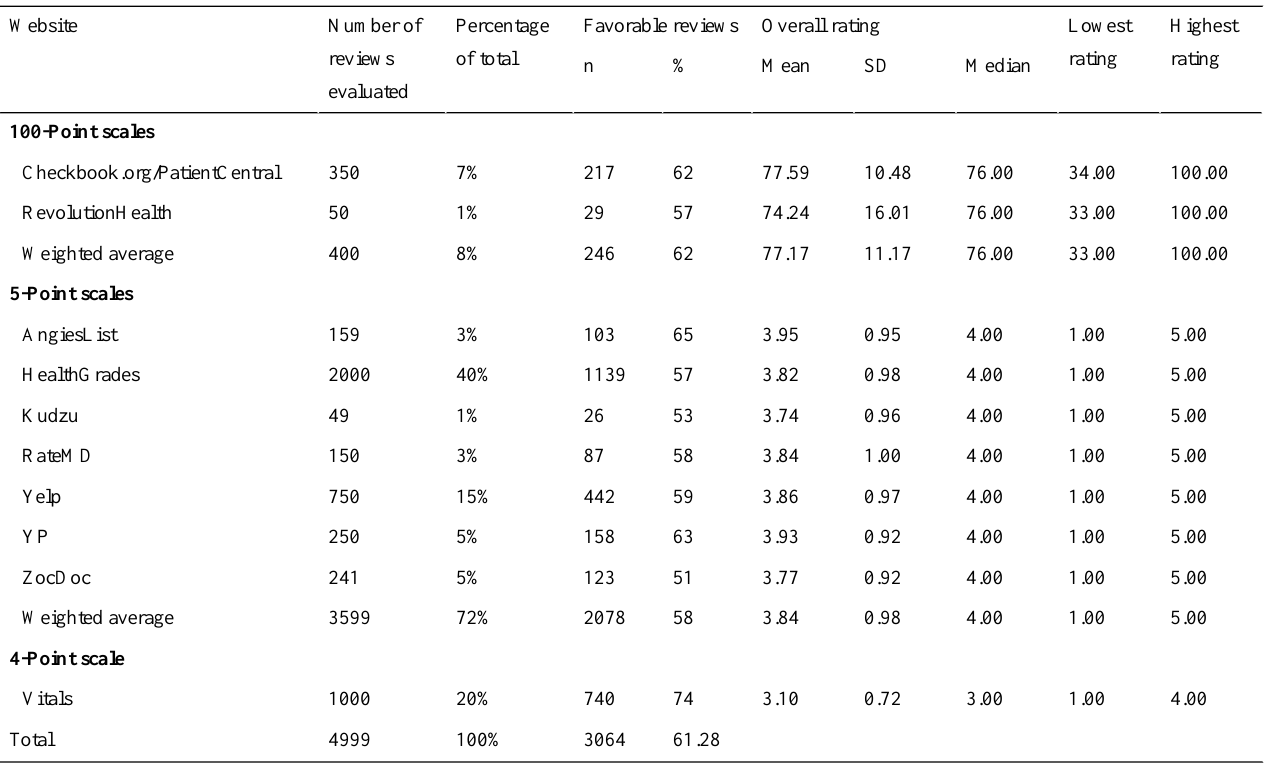
Table 4. Physician ratings from the top 10 physician-rating websites with user-generated content. Percentage favorable ratings defined as ≥ 3 of 4, ≥ 4 of 5, or ≥ 75 of